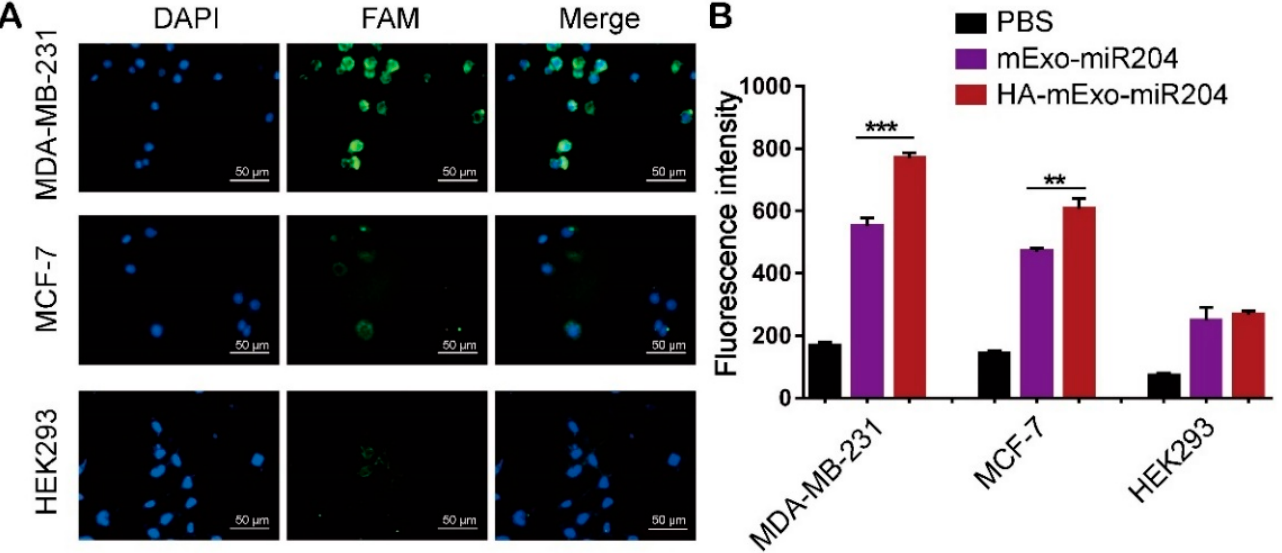
Figure 2. In vitro delivery specificity and efficiency of HA-mExo-miR204. ( A ) Immunocytochemistry analyses of miR-204 cellular uptake. Cancer cells were incubated with HA-mExo-miR204 for 2 h. Blue: nucleus stained by DAPI; green: FAM fluorophore-labeled miR-204. Scale bars: 20 μ m. ( B ) Quantitative analyses of miR-204 cellular uptake by determining the fluorescent signals inside the cells. ** p < 0.01, *** p < 0.001.